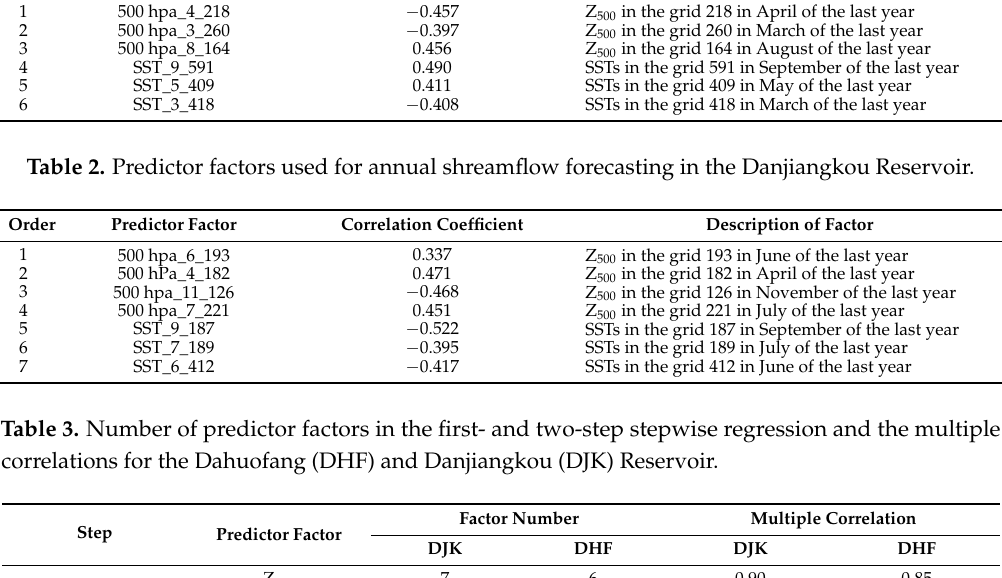
Table 1. Predictor factors used for annual shreamflow forecasting in the Dahuofang Reservoir. Order